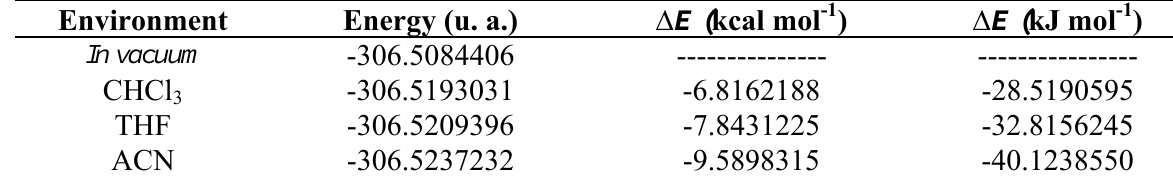
Table 4. Δ E of MAA in different solvents. solv